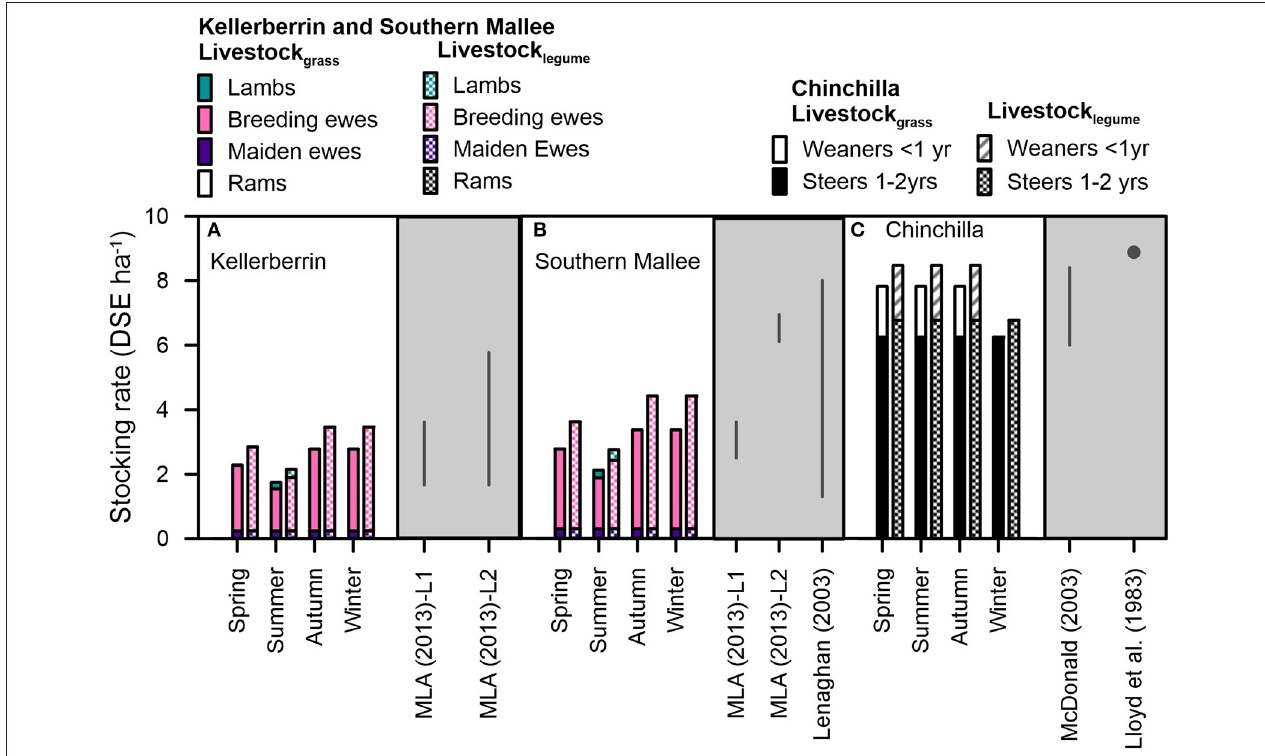
FIGURE 5 | Simulated stocking rates (white panels) and point values or range of values for reference stocking rates (gray panels) for the (A) Kellerberrin, (B) Southern mallee, and (C) Chinchilla case study farms. Note that rams at Kellerberrin and Southern Mallee represent ≤ 0.02 DSE ha − 1 of the overall stocking rate at these locations and are not visible in the bars. Permanent pastures consist of grass receiving 12.5–50kg N fertilizer ha − 1 yr − 1 (Livestock grass scenario; solid bars) and a legume pasture that was not fertilized with N (Livestock legume scenario; hatched